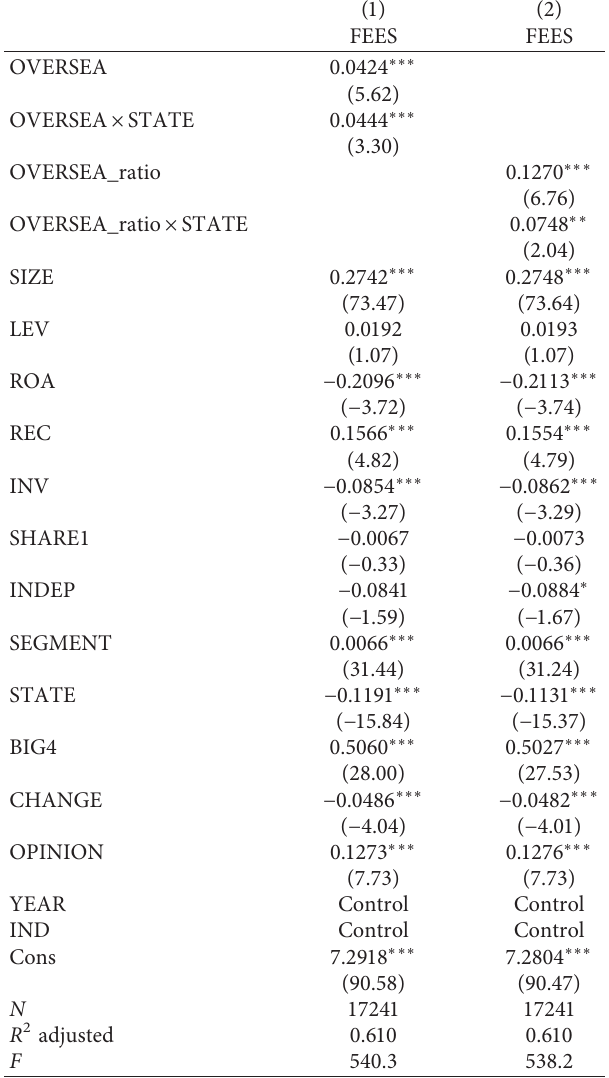
Table 7: Audit committee overseas experience, property right state, and audit